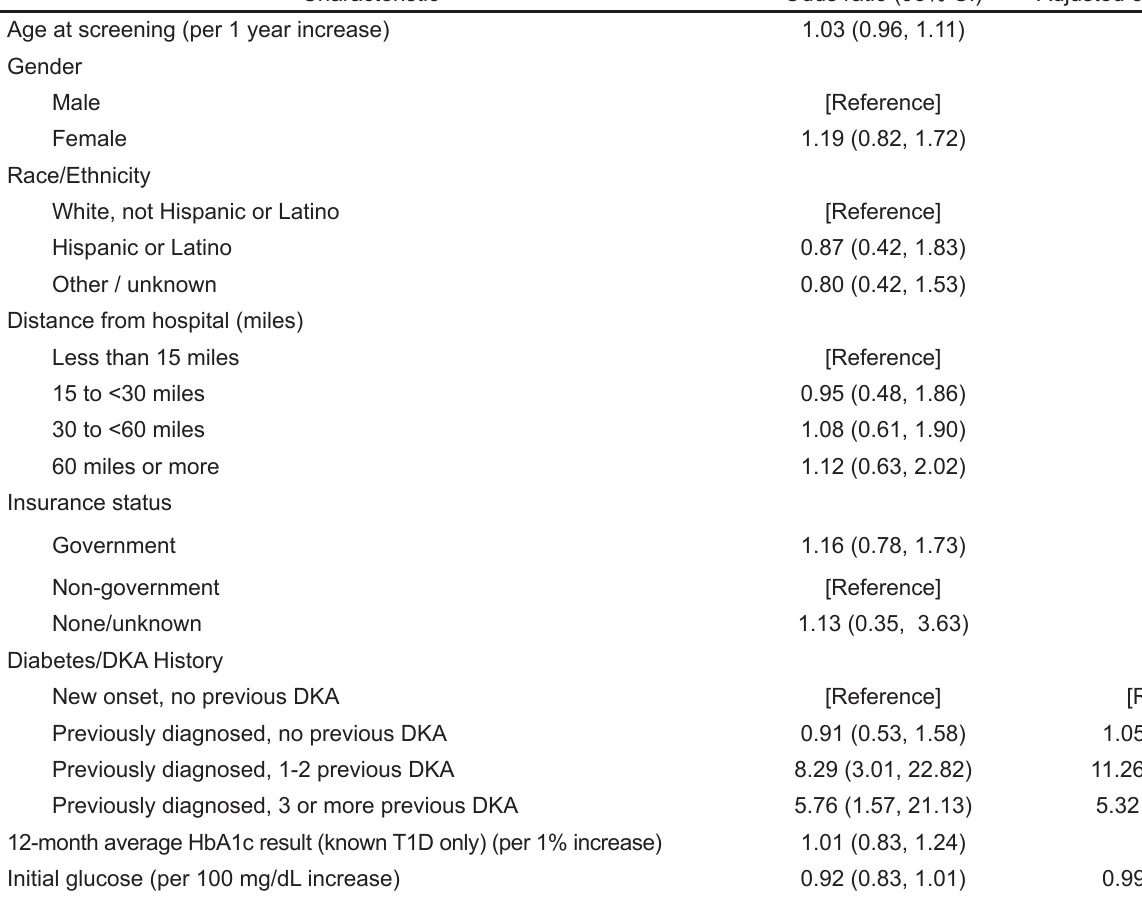
Table 2. Unadjusted and adjusted odds-ratio estimates for successful enrollment.*